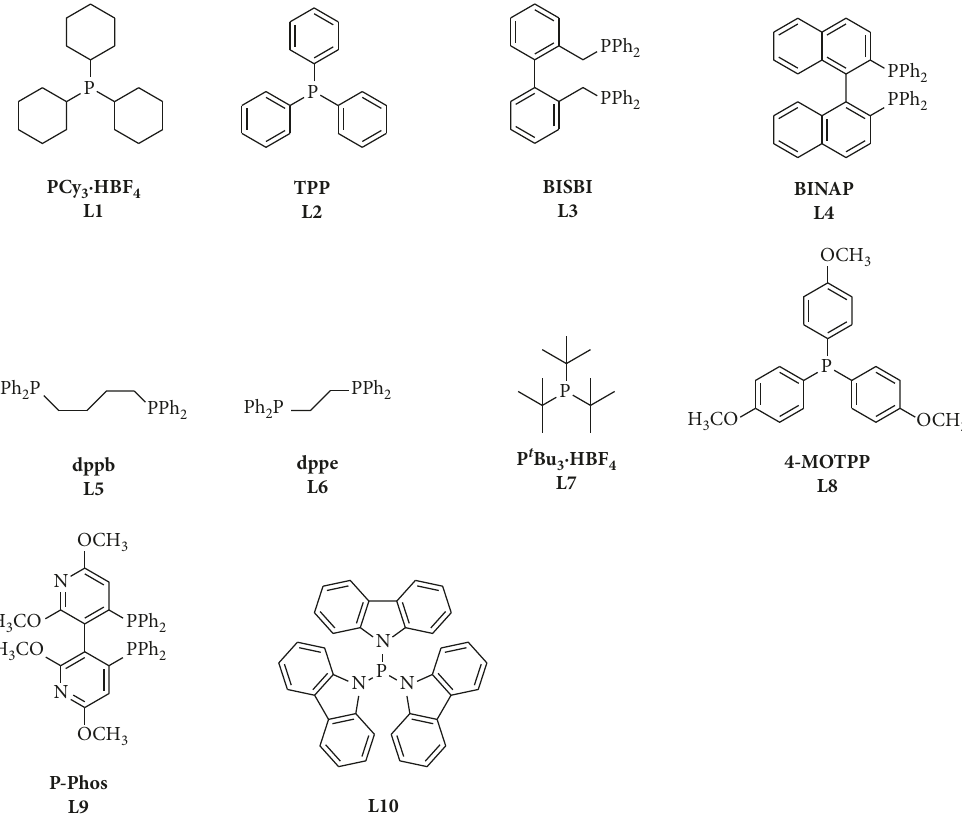
Scheme 2: Phosphine